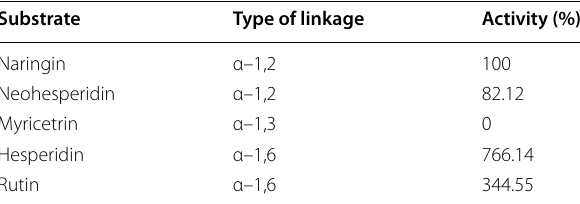
Table 1 Substrate specificity of recombinant α-L-rhamnosidase N12-Rha